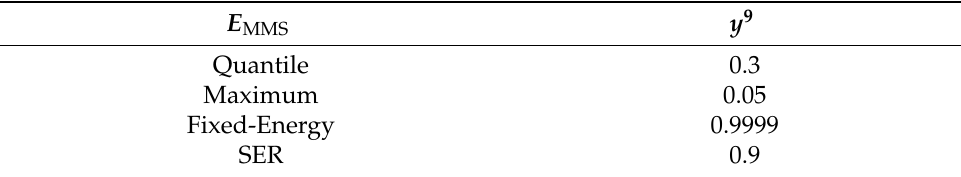
Table 1. θ parameter for verification with